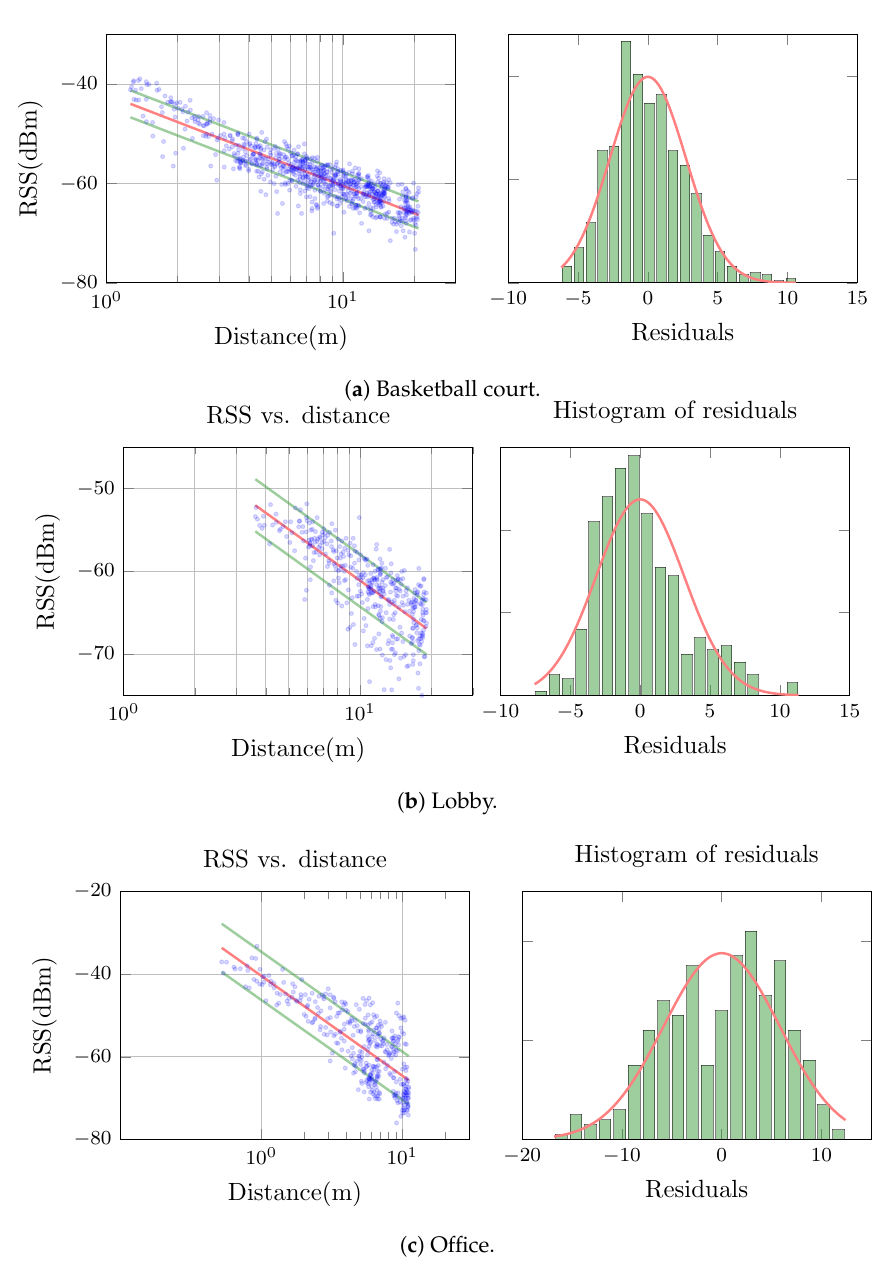
Figure 2. Examples of models identified in the different